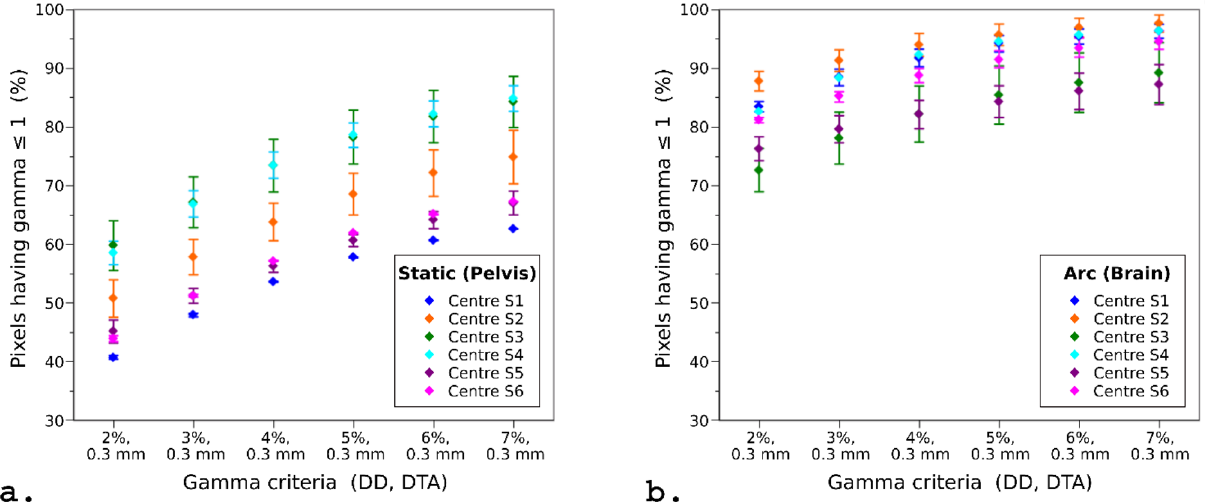
Figure 7. Results of the gamma analyses for all films from each centre for the ( a ) static beam (pelvis) and ( b ) arc (brain) plans. The number of static and arc films analysed for each centre were 2,2,2,2,2,2 and 2,2,1,2,2,3, respectively. The points represent the mean, and the error bars represent the range of results.